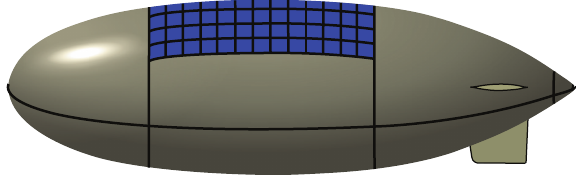
Figure 2: “Fish scale” design scheme for rigid solar array on stratospheric airship.